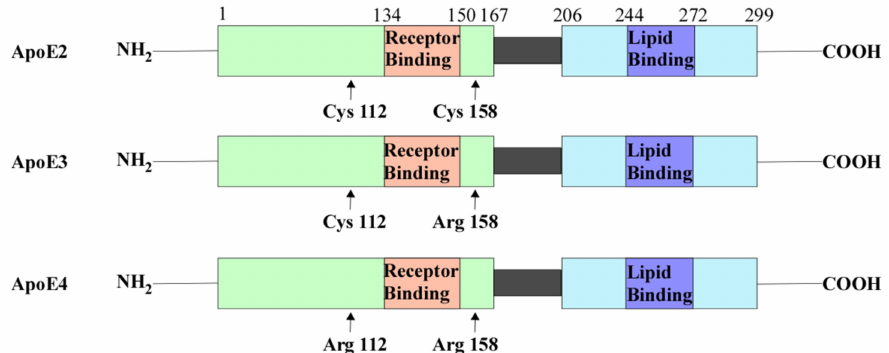
Figure 2. ApoE contains the N-terminal domain which contains the receptor-binding region and the C-terminal domain containing the lipid-binding region. There are three isoforms of APOE: ApoE2, ApoE3, and ApoE4. ApoE2 contains Cys residues at positions 112 and 158. ApoE3 contains a Cys residue at position 112 and an Arg residue at 158. ApoE4 contains Arg residues at both of these positions. Abbreviations: cysteine (Cys), arginine (Arg), apolipoprotein